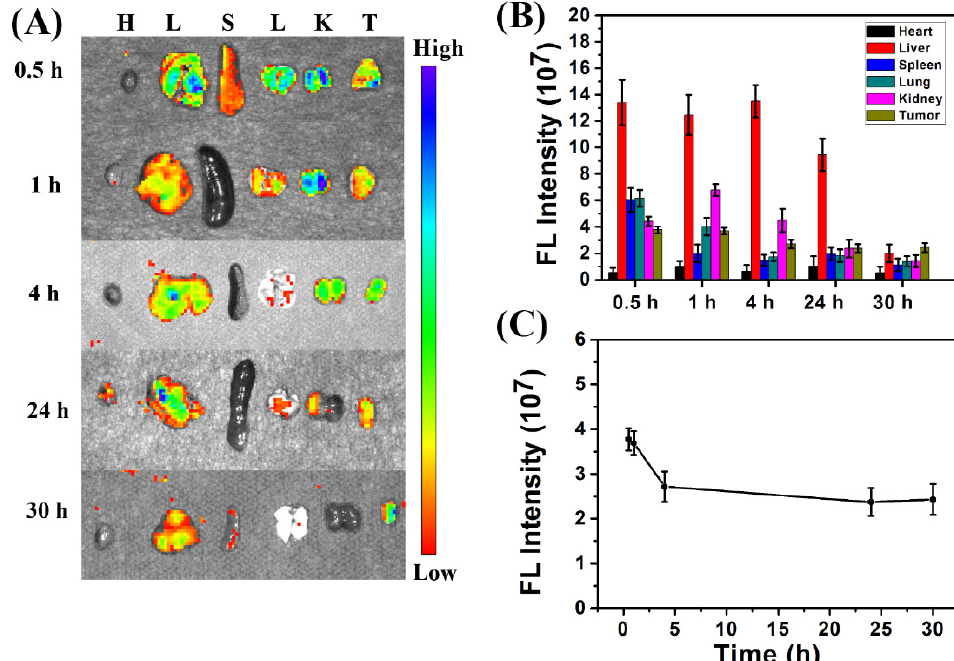
Figure 6. ( A ) Fluorescence image of ex vivo tissues (H, heart; L, liver; S, spleen; L, lung; K, kidney; T, tumor) isolated from mice after injection of CDs@PEI nanoparticles at 0.5, 1, 4, 24, and 30 h. ( B ) Average fluorescence (FL) intensities of major tissues and tumor at the designated time interval. ( C ) FL intensity curve of the tumor with specific time point.